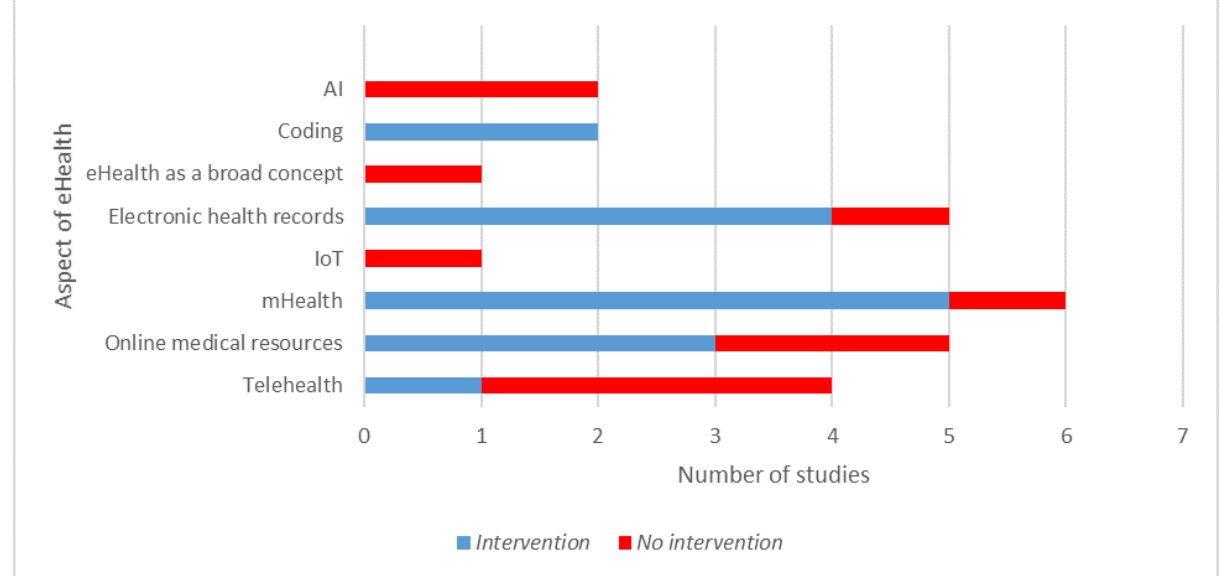
Figure 3. Number of articles discussing each aspect of eHealth. AI: artificial intelligence; IoT: internet of